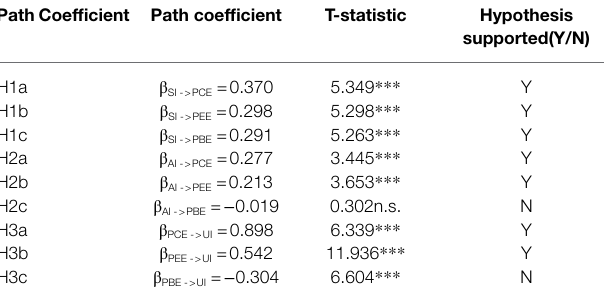
TABLE 5 | Result of the structural model. Path Coefficient Path coefficient